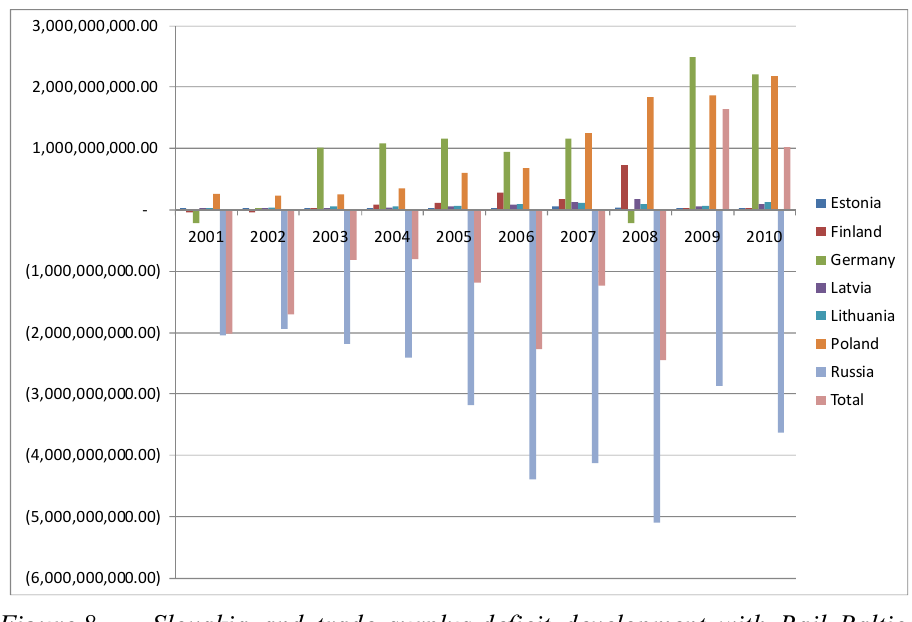
Figure 8 Slovakia and trade surplus-deficit development with Rail Baltica countries and in total during years 2001-2010 (currency used USD). Source for data: United Nations